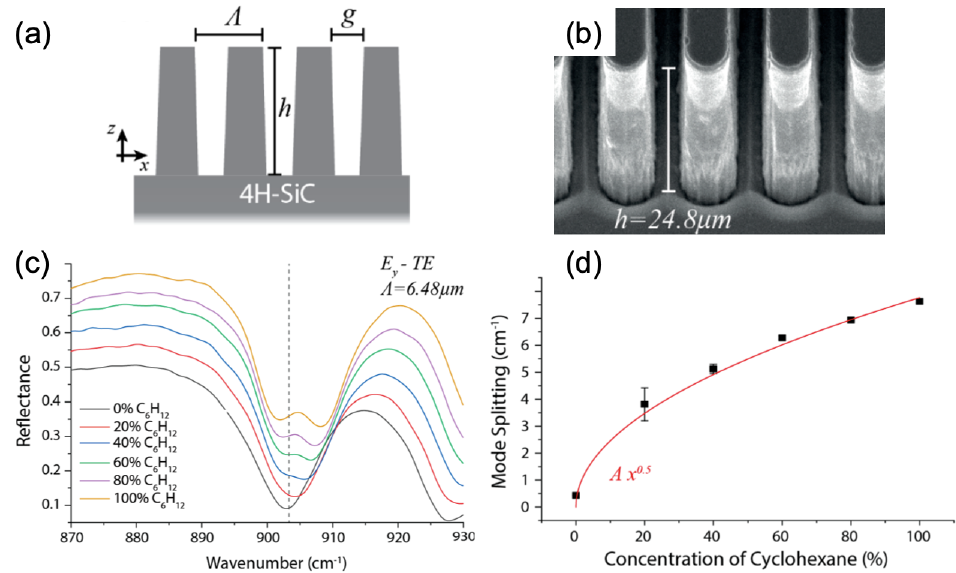
Figure 5. ( a ) Principle scheme of 4H-SiC high-aspect-ratio gratings (HAGs) with the tooth height h of grating, the grating period Λ and the tooth spacing of grating g . ( b ) SEM image of the 4H-SiC HAG. ( c ) Reflectance spectra with different concentrations of cyclohexane. The dashed line corresponds to the vibration mode of cyclohexane located at 903 cm − 1 . ( d ) Mode splitting versus cyclohexane concentration. The red line corresponds to the fit with a square root function. All the figures are reprinted (adapted) with permission from [81], Copyright 2020 American Chemical